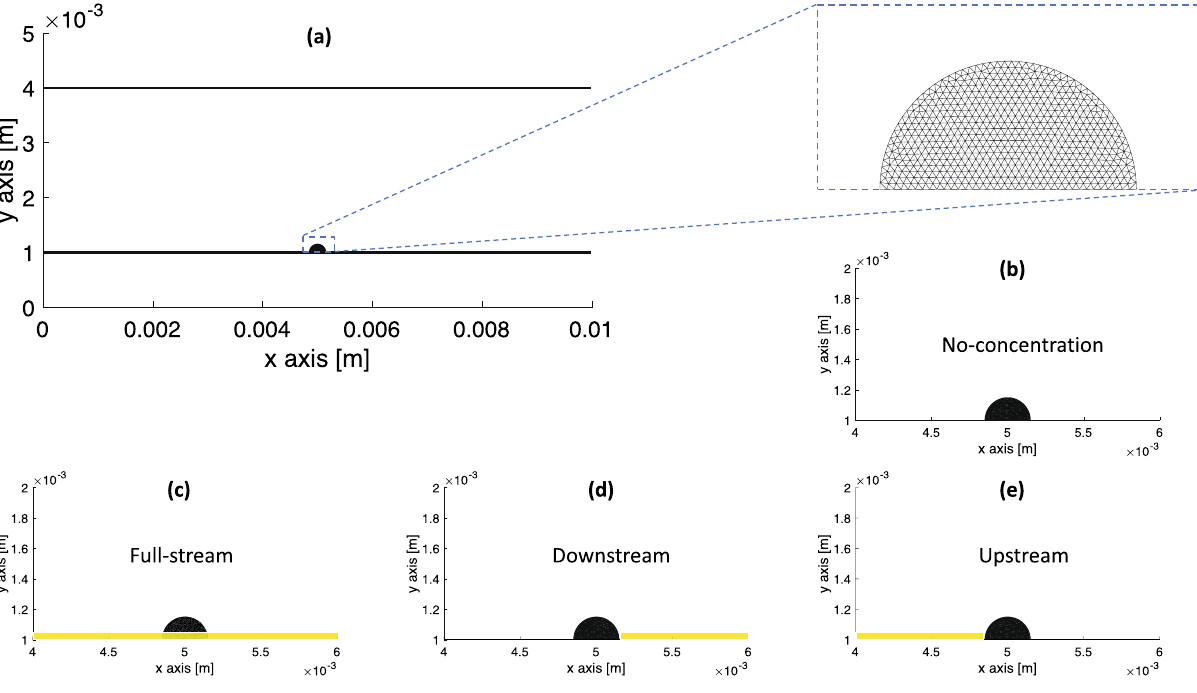
Figure 1. Initial simulation set up. ( a ) The initial configuration is a semicircular biofilm located at the bottom of the microchannel with a triangular mesh (inset) with Q 0 = 637 nodes, S 0 = 1819 viscoelastic elements, and N 0 = 1183 triangles. The periodic boundary condition is imposed at the inlet and outlet, and the no-slip boundary condition is implemented along the walls. ( b ) The base case of no-concentration used to simulate biofilm deformation in fluid flow without growth. ( c )–( e ) The test cases of concentration (yellow strip) to simulate growth under different nutrient conditions in the presence of fluid flow. During the simulation, the concentration within the yellow strip, which is one Eulerian grid width thick, is held constant at c 0 to simulate a continuous supply of